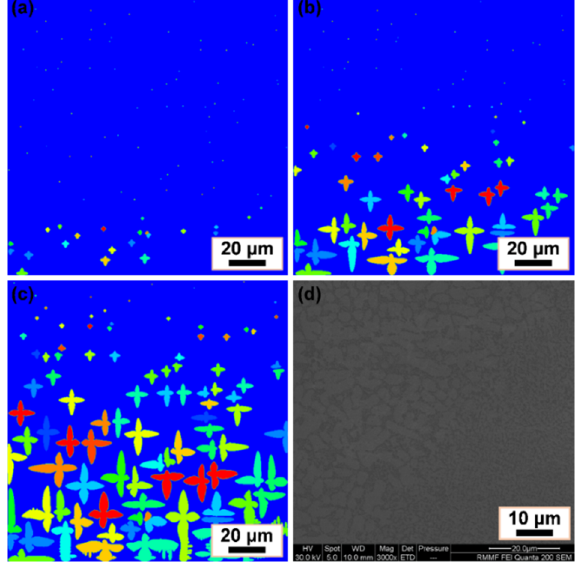
Figure 3. Simulation of dendrite growth at different times and experimental results: ( a ) t = 1.6 s; ( b ) t = 4.2 s; ( c ) t = 7.8 s; ( d ) SEM micrograph of dendritic morphology.